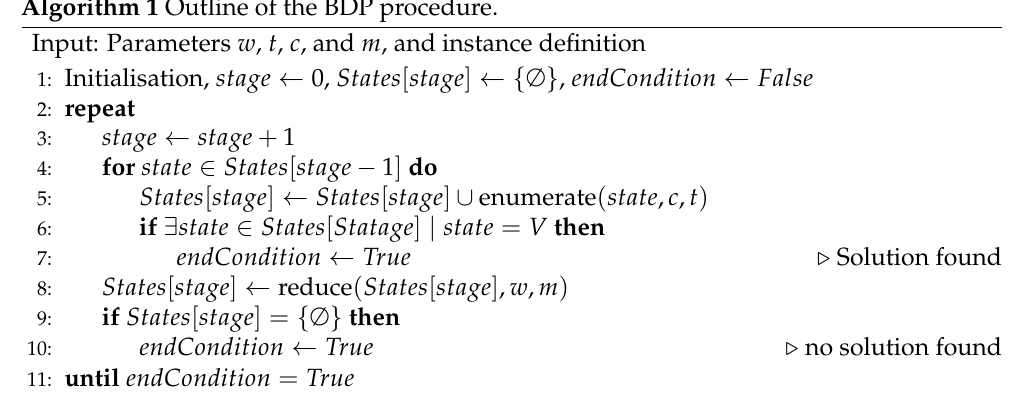
Algorithm 1 Outline of the BDP